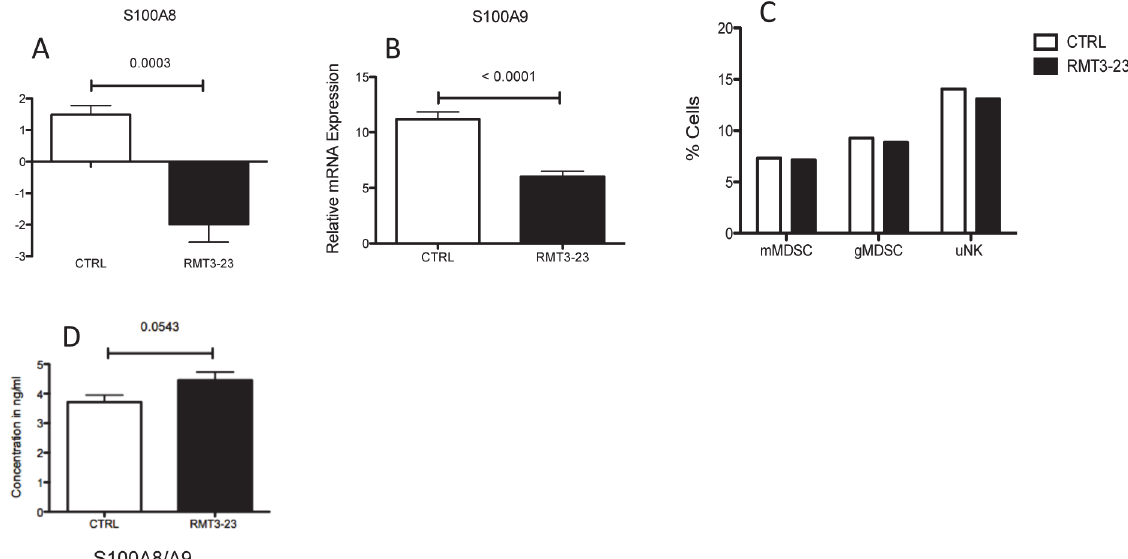
Fig 10. Effect of TIM-3 blockade on uterine MDSC population. Treatment with RMT3-23 did not change the size of the MDSC population in the uteri of pregnant CBA mice (C) although a significant decrease in the proinflammatory S100A8 (p = 0.0003) (A) and A9 (p < 0.0001) (B) proteins in the placentae was observed. No change was observed in the concentration of the S100A8/A9 proteins in the RMT3-23 treated mice sera (D). Data are presented as mean ± SEM and are representative of at least 3 experiments. Statistical analysis was done using unpaired t